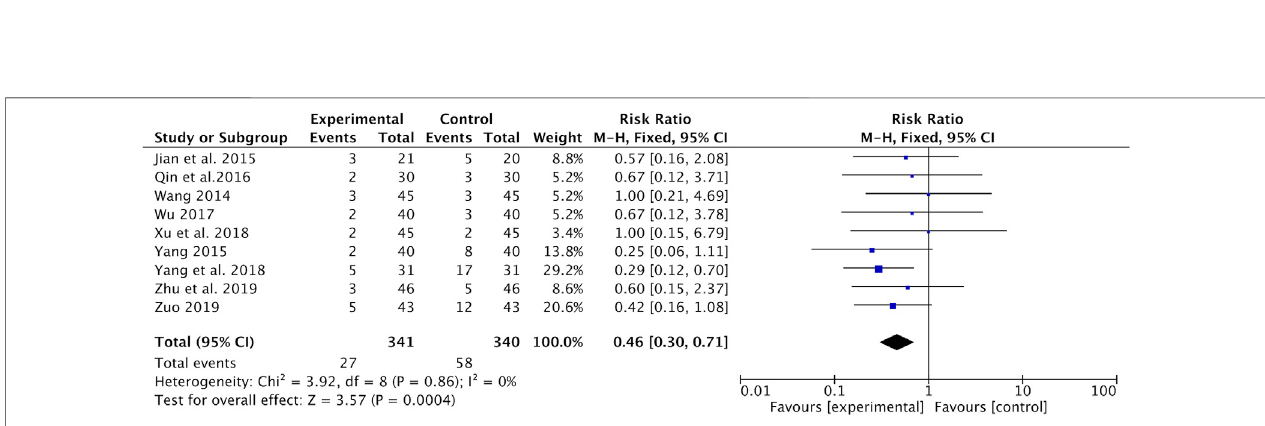
FIGURE 8 | Forest plot of hepatic and renal toxicity of Astragalus-containing CHM combined with CT vs. CT alone. CHM, Chinese herbal medicine; CT, chemotherapy.